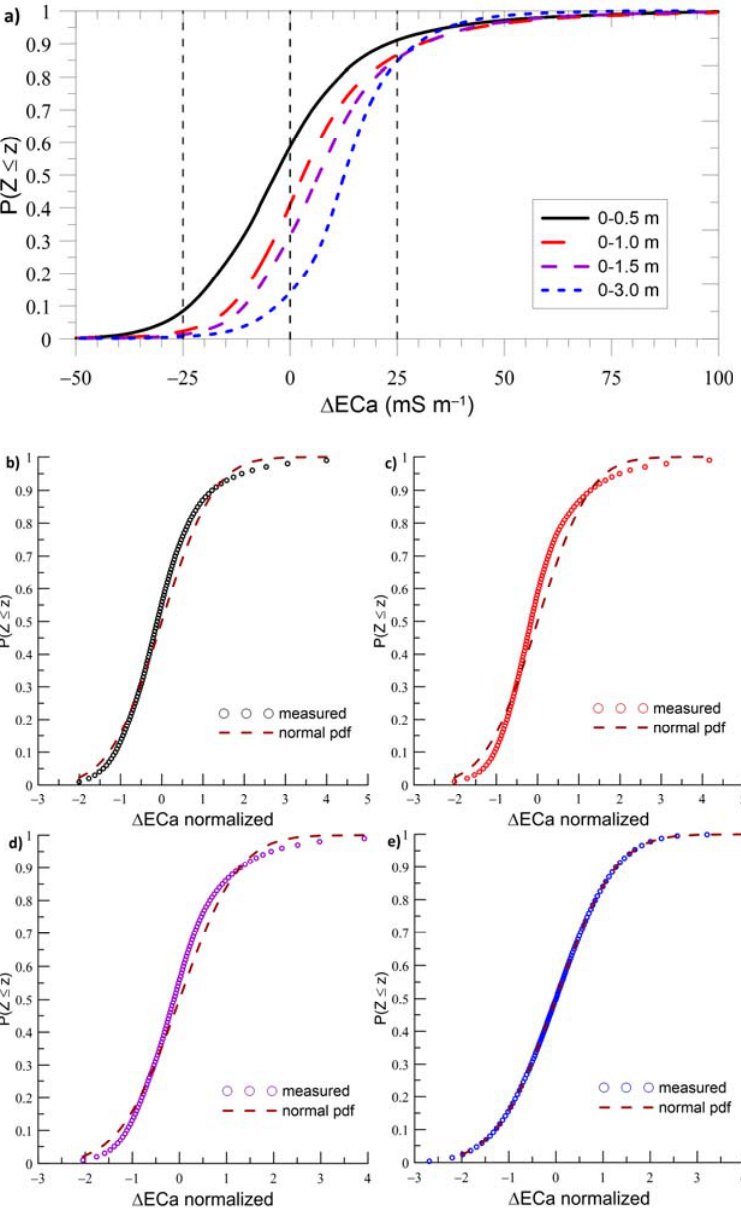
Figure 4. ( a ) Cumulative distribution functions of the increments in interpolated ECa between 2013 and 2017 ( ∆ ECa) for the four interpolated signals shown in Figure 3. Comparison with the normal distribution for DOEs of ( b ) 0–0.5 m; ( c ) 0–1.0 m; ( d ) 0–1.5 m and ( e ) 0–3.0 m.